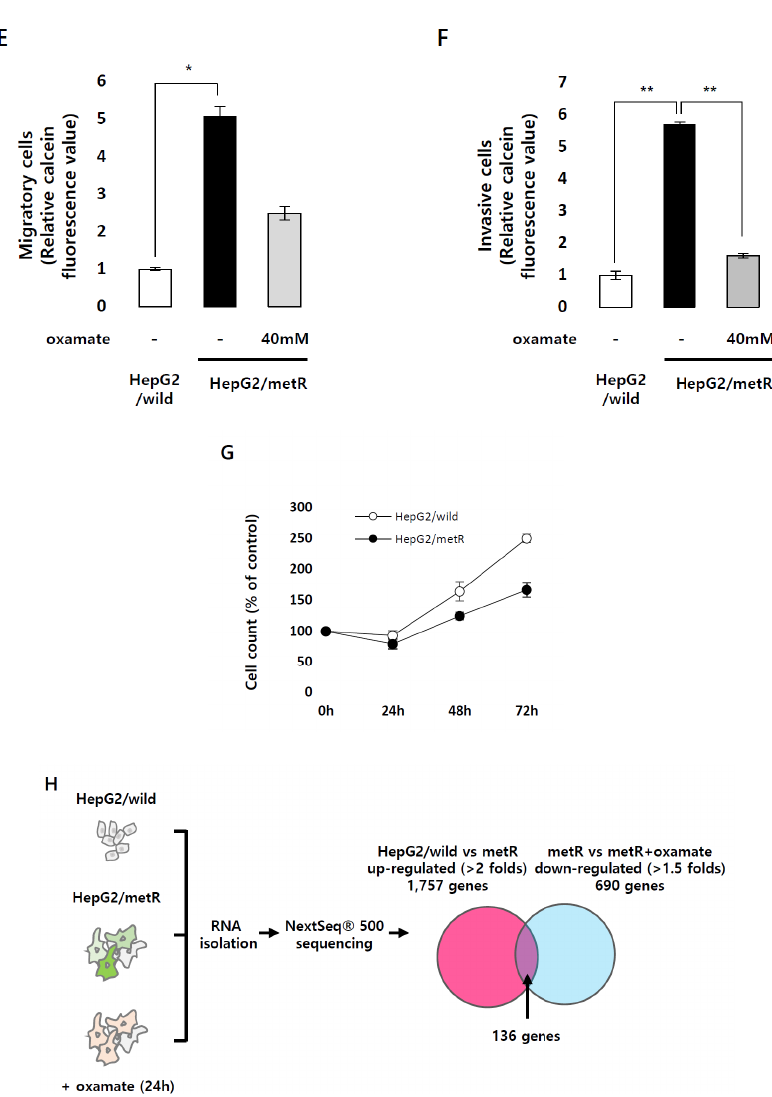
Figure 1. Identification of genes differentially expressed in a lactate-enriched microenvironment. ( A ) Kinetic extracellular acidification rates (ECAR) response of parental HepG2 and HepG2/metR cells to glucose (20 mM), oligomycin (1 µ M), and 2-DG (50 mM), respectively. ECAR values were normalized by the BCA protein assay. A representative experiment out of at least three trials is shown. ( B ) The glycolytic activity was measured by quantitatively estimating the conversion of glucose to pyruvate in HepG2 and HepG2/metR cells after the addition of a saturating amount of glucose to a given cell. p -value was assessed by Student’s t -test using data from triplicate experiments. * p < 0.05 and ** p < 0.01 vs. control. ( C ) Extracellular lactate production by HepG2, HepG2/metR, and oxamate-treated HepG2/metR cells. Results are mean ± SD of three experiments. The p -value was assessed by Student’s t -test. * p < 0.05 and ** p < 0.01 vs. control. ( D ) Intracellular lactate production by HepG2, HepG2/metR, and oxamate-treated HepG2/metR cells. Results are mean ± SD of three experiments. The p -value was assessed by Student’s t -test. ( E , F ). Migratory and invasive properties of HepG2, HepG2/metR, and oxamate-treated HepG2/metR cells as represented by relative calcein-AM fluorescence values. Results from three independent experiments are shown as mean ± SD. * p < 0.05 and ** p < 0.01 vs. control by Student’s t -test. ( G ) Growth of HepG2 and HepG2/metR cells were quantitatively estimated by cell counting during indicated time period. Results from three independent experiments are shown as means ± SD. ( H ) Schematic illustration of the RNA-sequencing strategy to profile lactate-induced gene